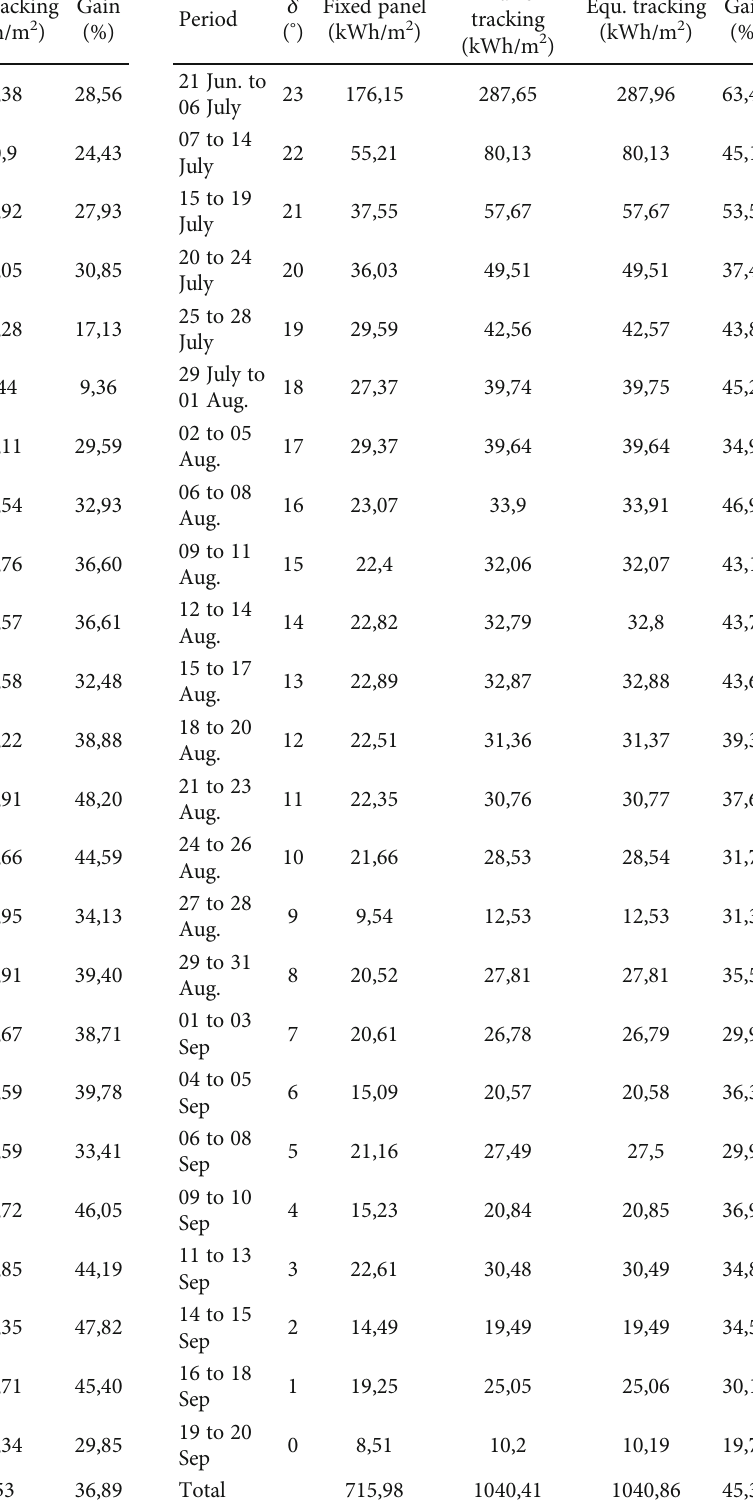
Table 1: The results of the spring simulation. Table 2: The results of the summer